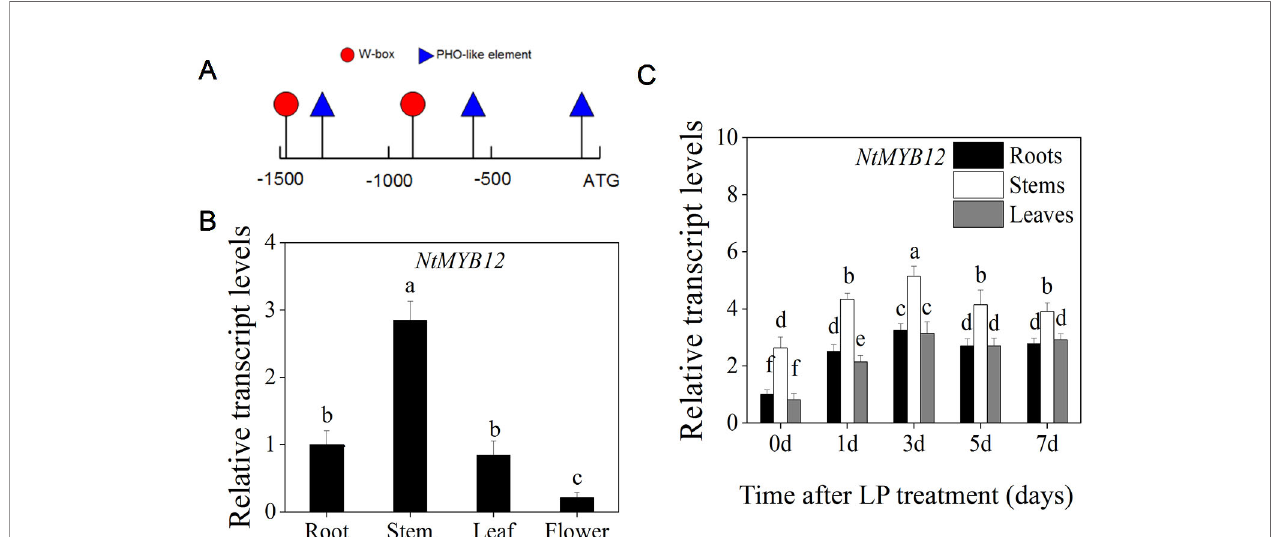
FIGURE 3 | Expression patterns of NtMYB12 in different organs and effects of Pi deprivation on the expression of NtMYB12 in tobacco. (A) Analysis of the NtMYB12 promoter. (B) Relative transcript levels of NtMYB12 in different tissues of tobacco. (C) Time course of NtMYB12 expression in response to low Pi stress. Thirty-day old seedlings were grown in nutrient solution with low Pi (LP; 0.02mM Pi) for 7 days. Data are the means ± SDs of fi ve biological replicates. Different letters indicate signi fi cant differences ( P <